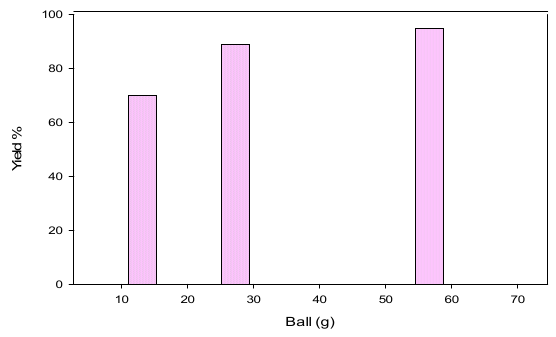
Figure 2. Milling of 2.5 g of o -phenylenediamine and 3 g of benzoic acid at 20 Hz for 60 min.